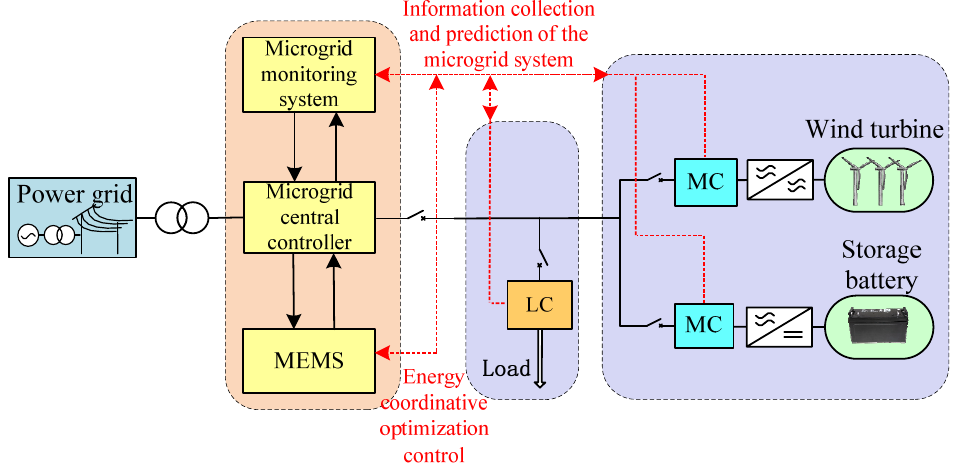
Figure 1. Topological structure of a microgrid